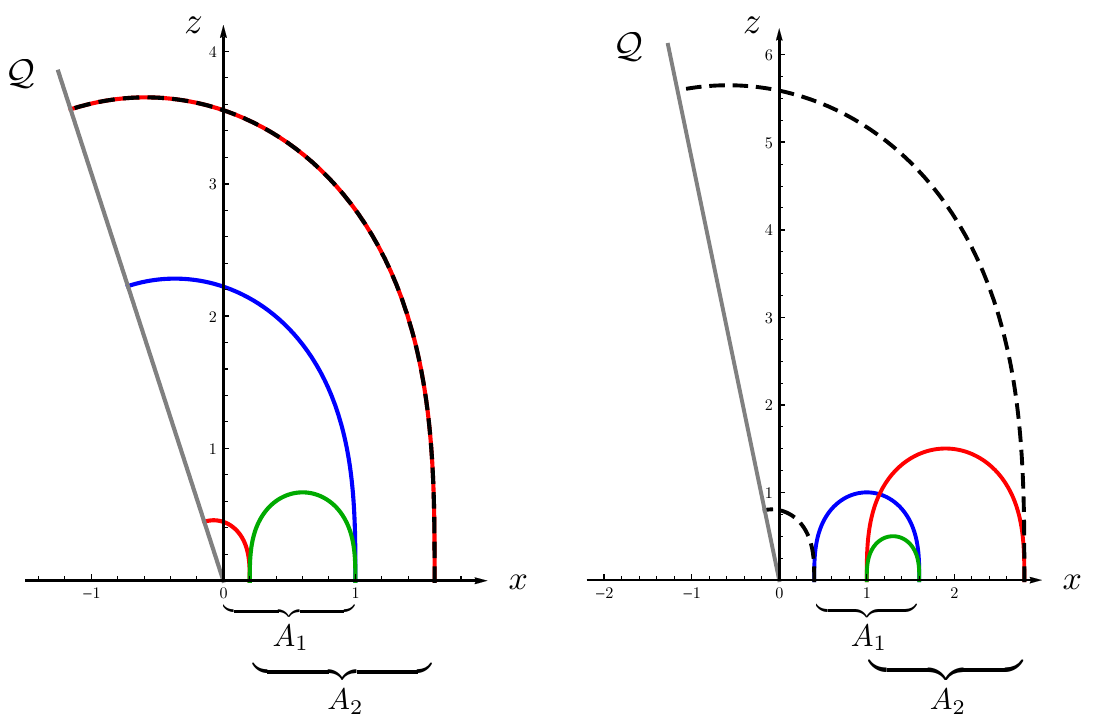
Figure 25 . Con(cid:12)gurations of two in(cid:12)nite strips A 1 and A 2 such that A 1 \ A 2 6 = ; , with the corresponding minimal surfaces, which have been employed in section E. The blue solid curve corresponds to ^ (cid:13) A , the red solid curve (which is made by two components in the left panel) to ^ (cid:13) A , 1 2 the green solid curve to ^ (cid:13) A and the black dashed curve (which is made by one component in 1 \ A 2 the left panel and by two components in the right panel) to ^ (cid:13) A . Left: A 1 is adjacent to the 1 [ A 2 boundary while A 2 is parallel to the boundary at a (cid:12)nite distance from it. Right: both A 1 and A 2 are parallel to the boundary at (cid:12)nite distances from